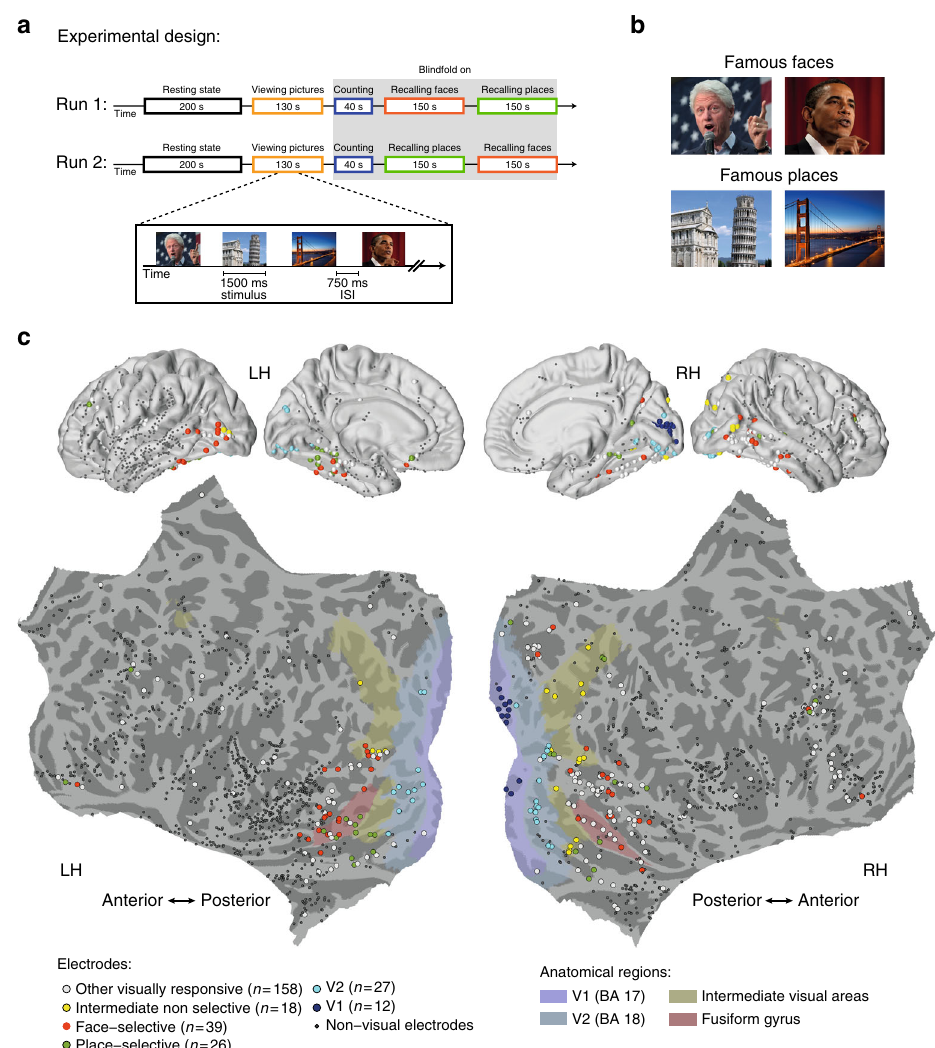
gyrusElectrodes: Intermediate visual areas Fusiform Fig. 1 Experimental design, stimuli, and electrode locations. a Participants viewed pictures of famous people and places, and after a short distraction task, were instructed to freely recall items from each category at a time. b Example of pictures from the two categories. Participants were instructed to remember the pictures in as much detail as possible, focusing on colors, face expressions, perspective, and so on. Photo of Bill Clinton courtesy of Gage Skidmore; photo of the Golden Gate Bridge courtesy of Nicolas Raymond; photo of the Leaning Tower of Pisa courtesy of Josu. These pictures are all published under a Creative Commons license. Photo of Barack Obama courtesy of the US Government. c Multi-patient electrode coverage. Recording sites in each patient were localized based on post-operative CT and MRI scans; the cortical surface was then reconstructed using FreeSurfer and standardized using SUMA to allow visualization of electrodes from different patients on a single cortical template (see Methods section). Visually responsive electrodes were attributed based on anatomical and functional criteria to one of the following subgroups: V1 (blue); V2 (light blue); category non-selective intermediate visual areas (yellow); face selective (red); and place selective (green). Note the clear tendency of category selective electrodes to be localized in high-order visual areas along the ventral stream. See Supplementary Table 2 for further details. (Abbreviations: RH — right hemisphere; LH — left